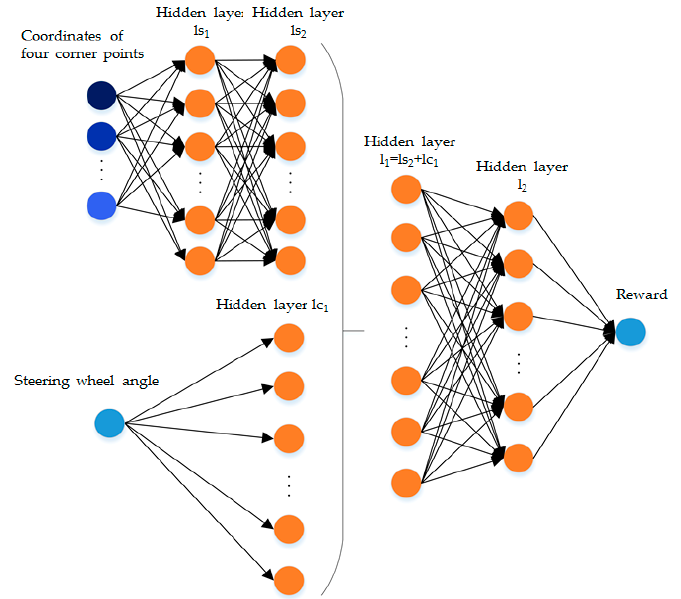
Figure 9. The structure of critic network and target critic network.